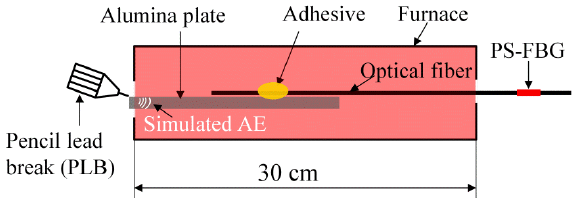
Figure 12. Experimental setup for detecting the simulated AE signals generated using PLB.